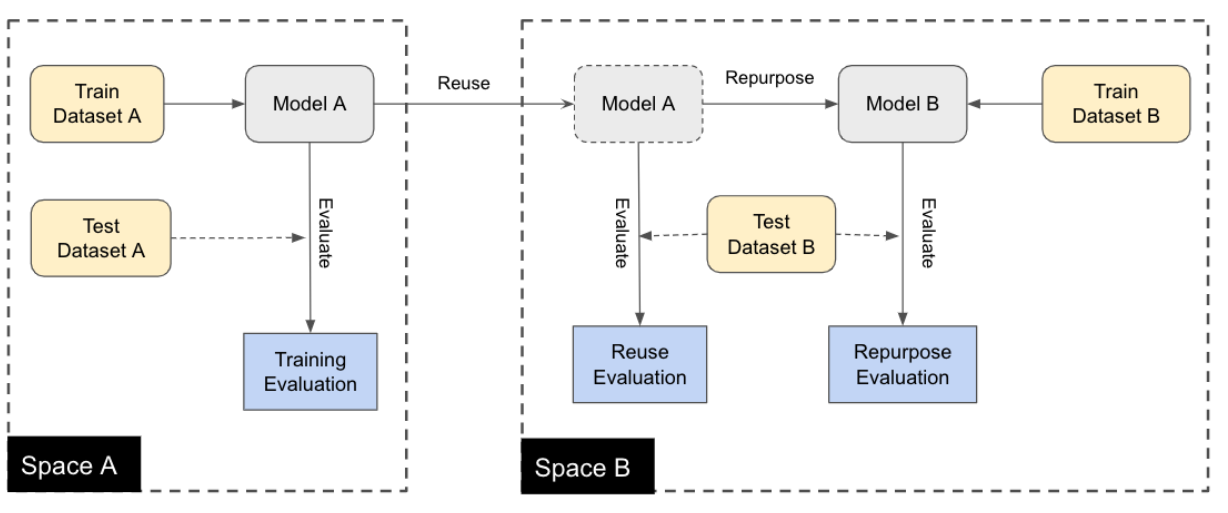
Figure 4. Methods for reusing the cognitive knowledge captured as machine learning